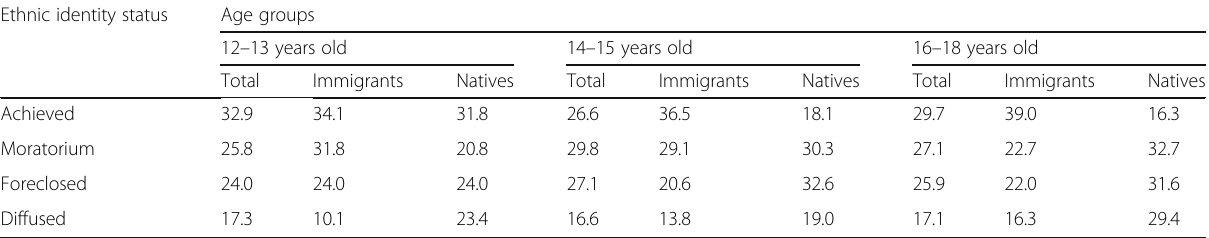
Table 1 Proportion of participants (total sample, immigrants and natives) in each ethnic identity status cluster by age group Ethnic identity